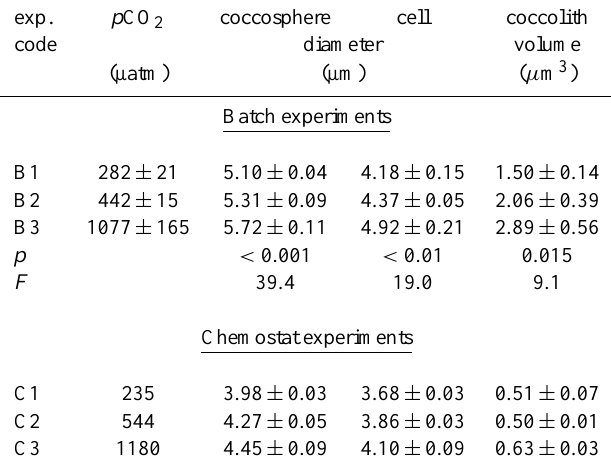
POC:TPN ratios remained unchanged (Table 3) which sug- gests that the phosphorus metabolism was partly decoupled from the C and N 28